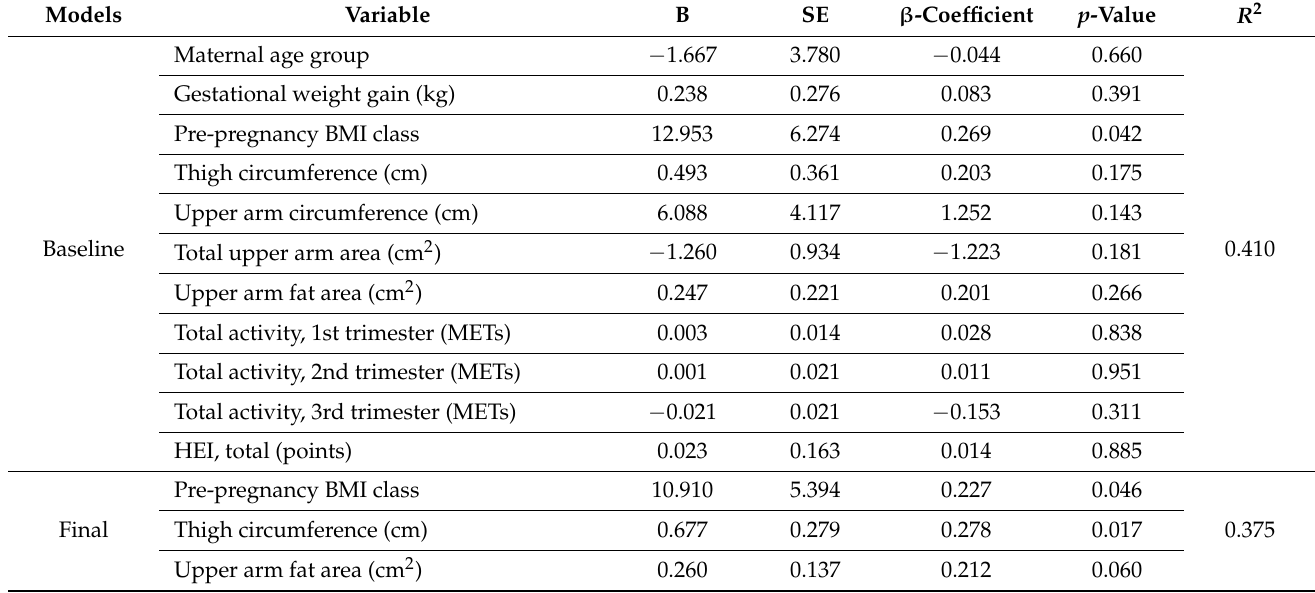
Table 6. Multiple linear regression: Leptin as an outcome variable (baseline and final model, n =